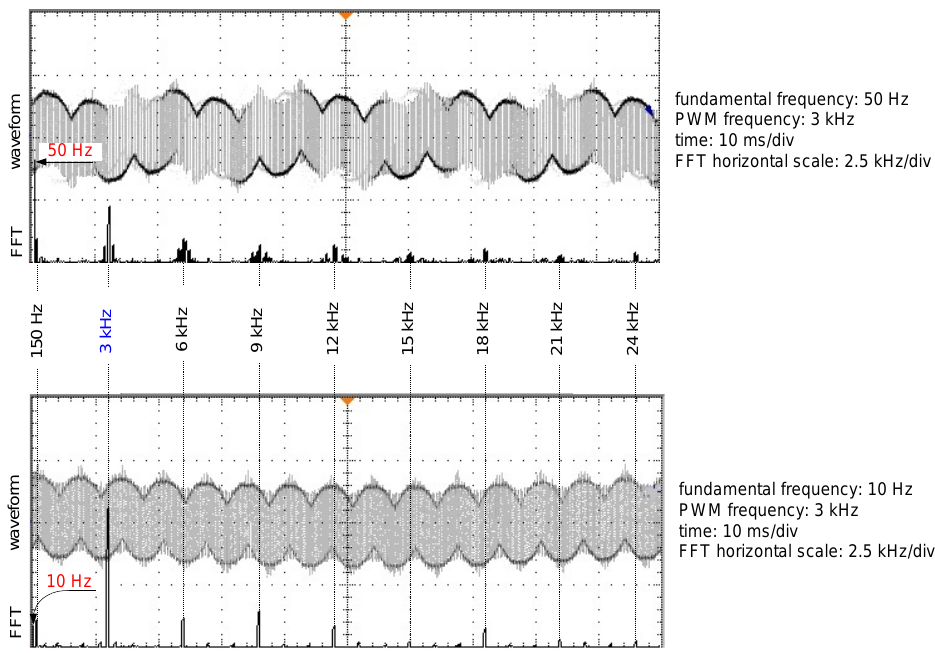
Figure 4. A variable-speed drive circuit producing residual currents of high-frequency components; RCD—residual current device; i ∆ —residual current; PWM—pulse width modulation.